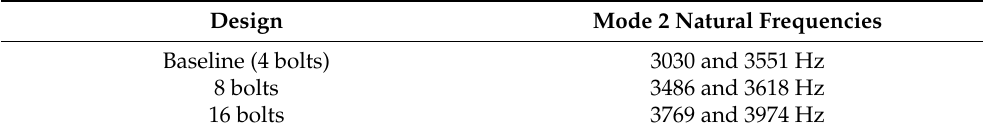
Table 7. Mode 2 natural frequencies of increased bolt designs.